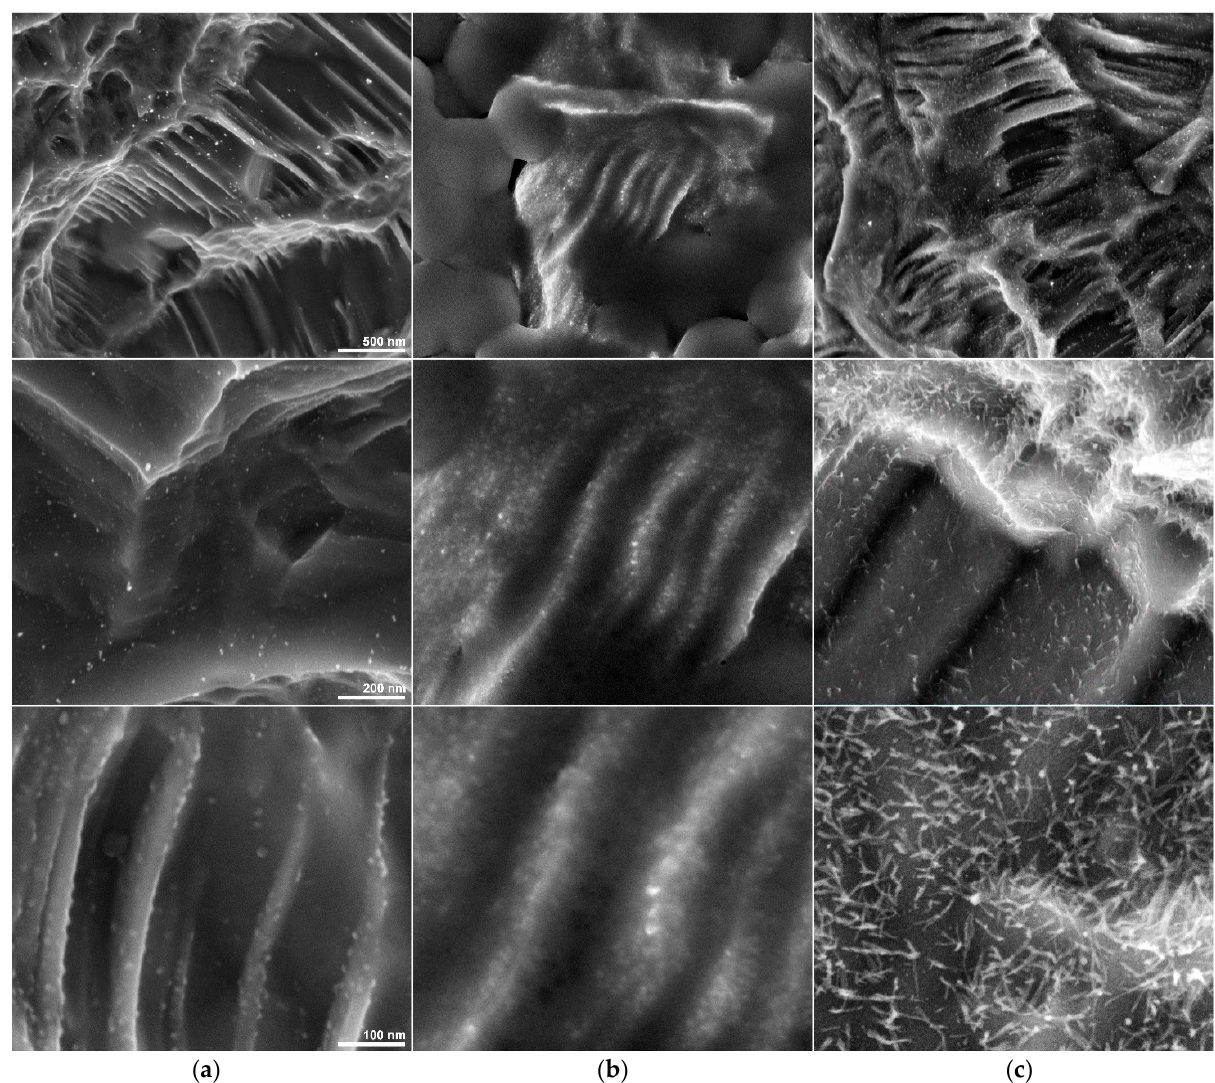
Figure 3. High-magnification SEM micrographs showing the different appearance and density of the nanostructures (horizontal field widths of 2.98 µ m 1.19 µ m and 597 nm, respectively) of ( a column ) ABT, ( b column ) Nano and ( c column ) Nano H 2 O. The magnifications are 100,000×, 250,000×, 500,000×, respectively for the first, second and third line of photos.